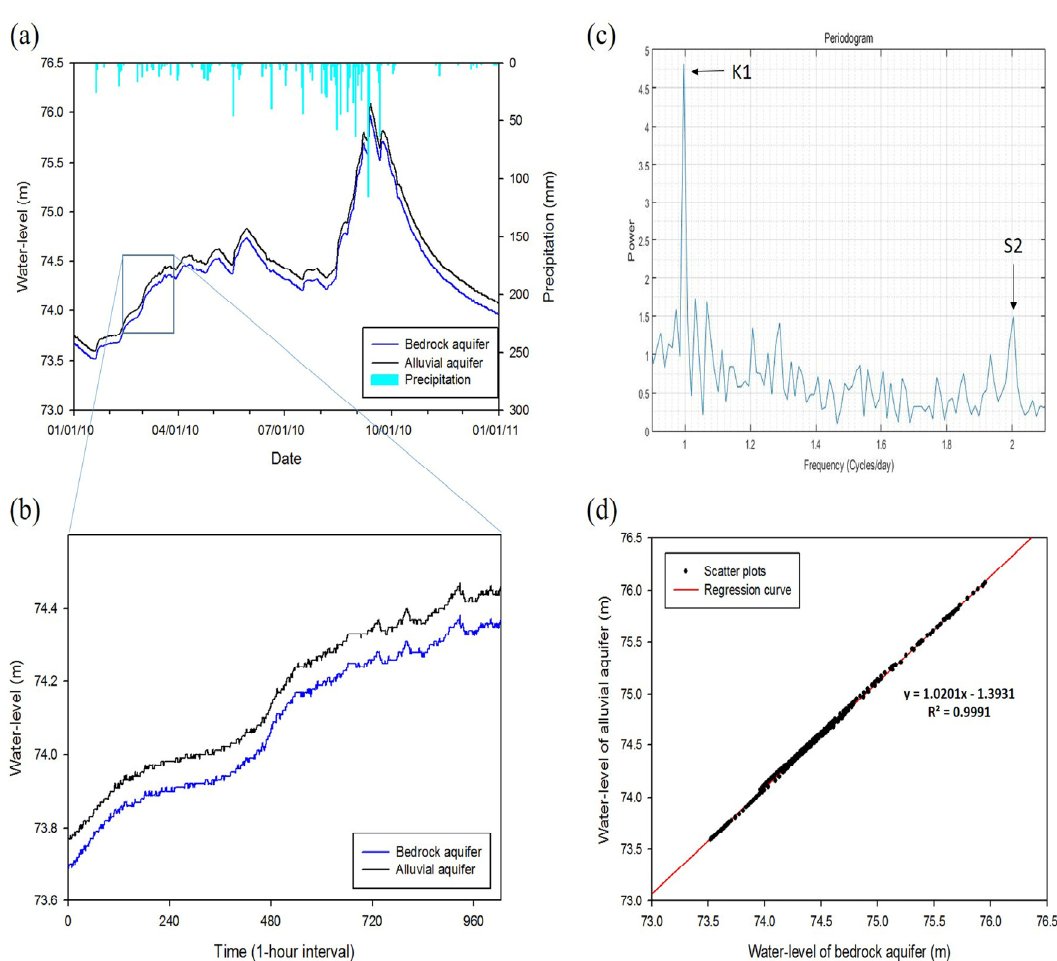
Figure 6. Results of the correlation analysis and harmonic analysis of the paired water-level data from shallow and deep monitoring wells in 2010 for Type I with identical pattern, high correlation coefficient, and the same unconfined/confined aquifer: ( a ) groundwater hydrograph; ( b ) one-hour interval data for spectral analysis; ( c ) signal components; and ( d ) correlated data.